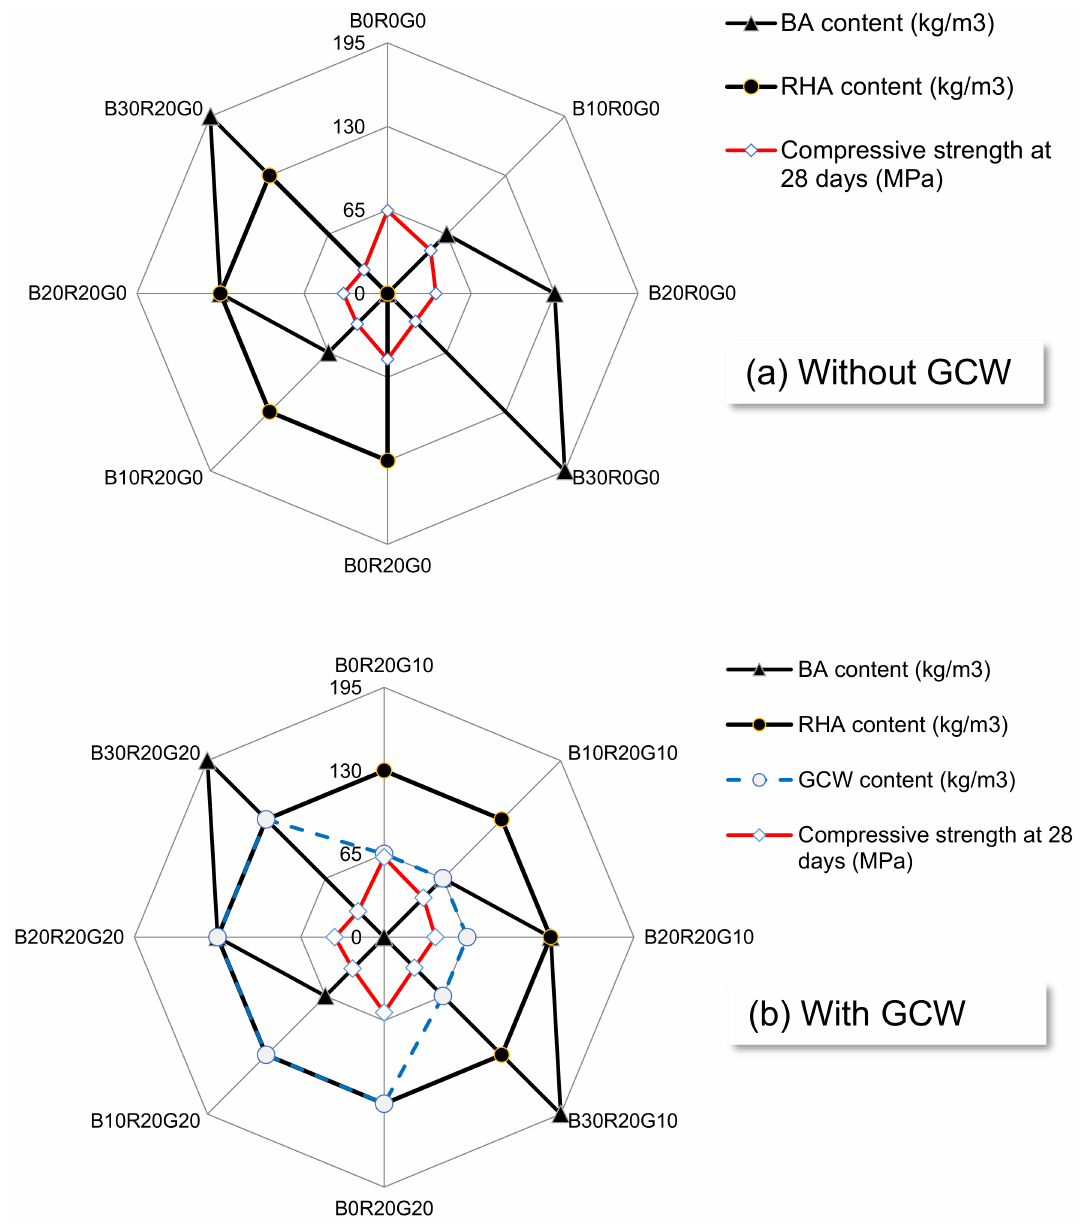
Figure 3. The relationships between compressive strengths of concretes and cement substitution levels of GCW, RHA, and BA in gSCC mixtures. ( a ) without GCW and ( b ) with